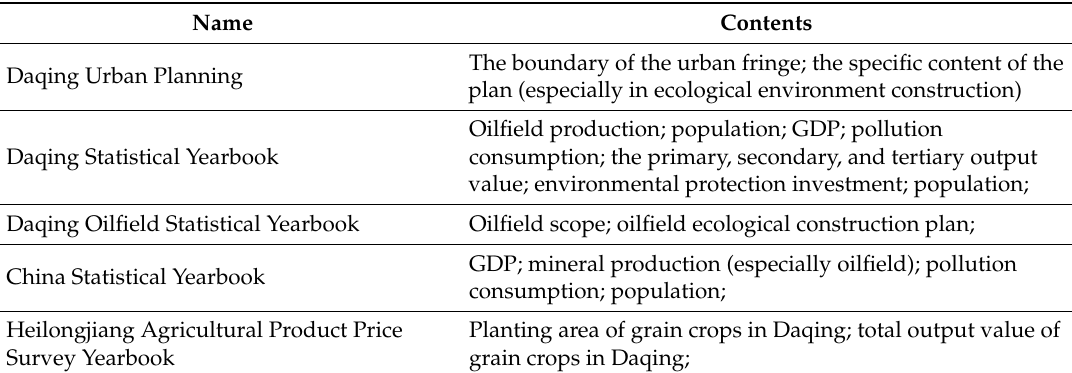
Table 2. Socioeconomic information 1980–2017.